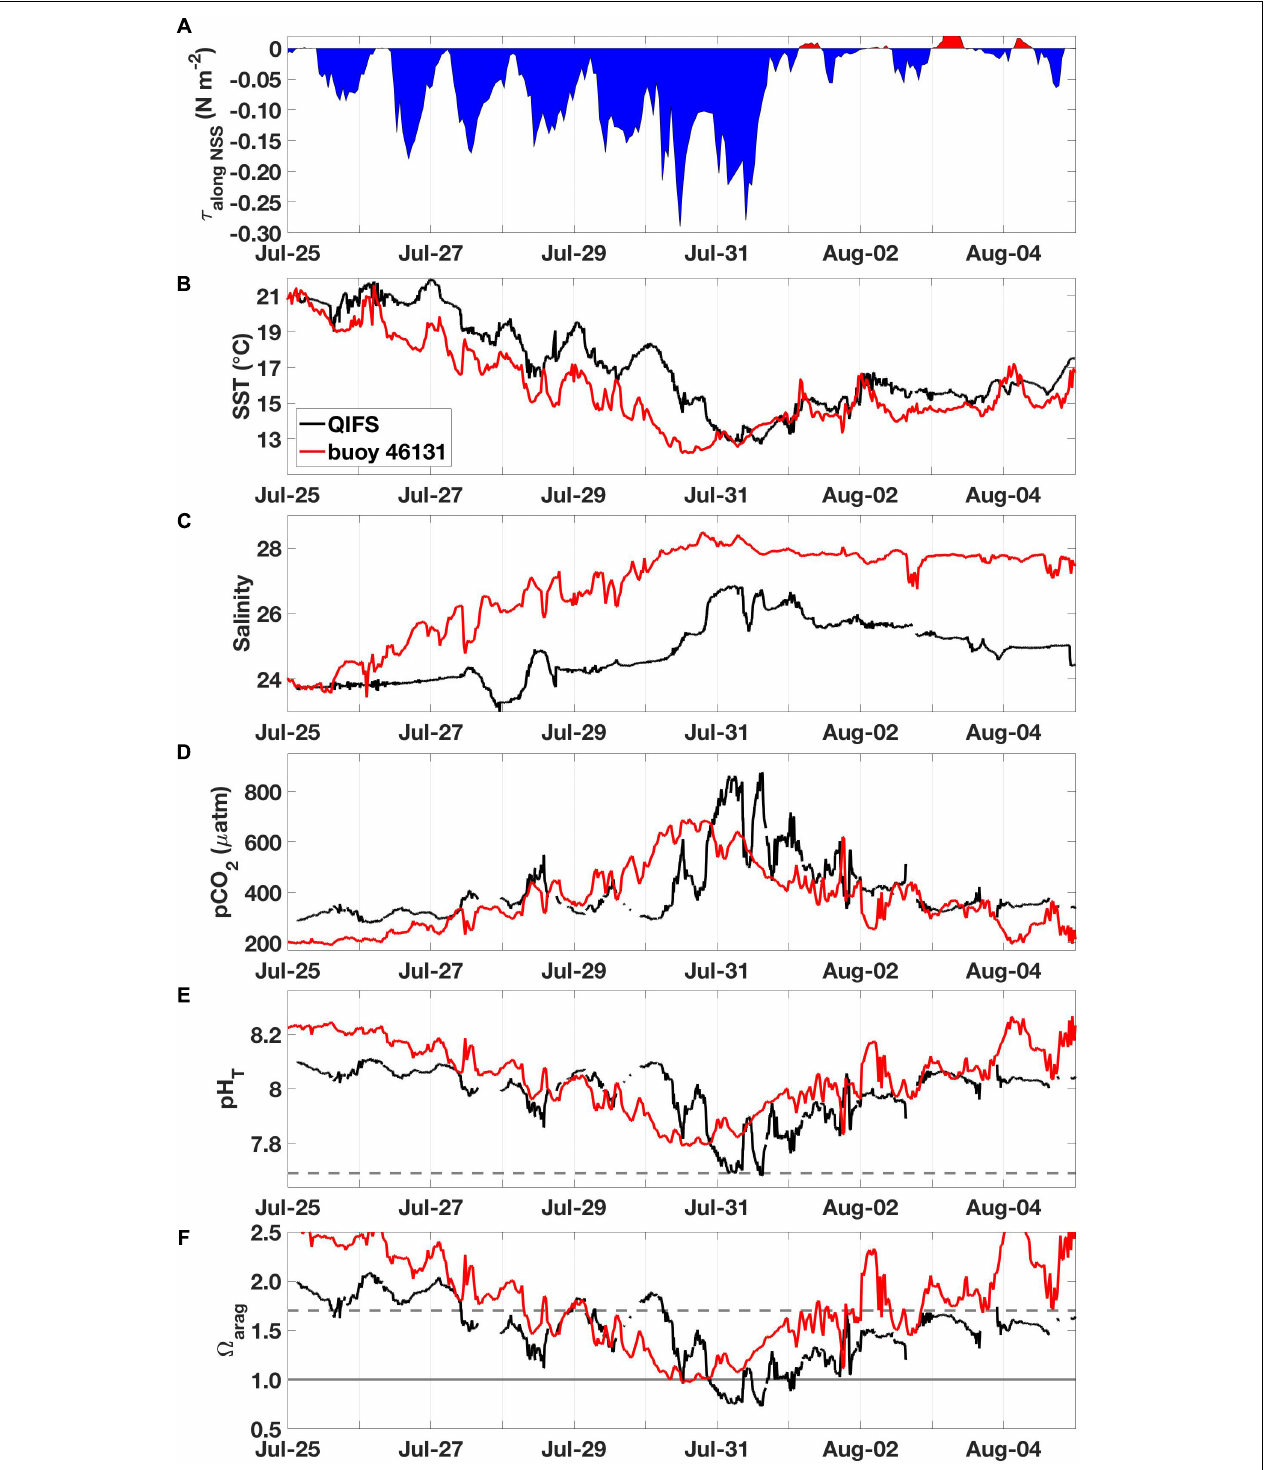
FIGURE 5 | Observations made during the July 2016 high-CO 2 event, including: (A) along-axis wind stress ( τ alongNSS ; N m − 2 ) from buoy 46131, (B) SST ( ◦ C) from QIFS and buoy 46131, (C) salinity from QIFS and buoy 46131, (D) seawater pCO 2 ( µ atm) from QIFS and buoy 46131, (E) pH T from QIFS and buoy 46131, and (F) (cid:127) arag from QIFS and buoy 46131. All QIFS data are black while buoy 46131 data are red. The horizontal line in (E) marks pH T = 7.69, and the horizontal lines in (F) mark (cid:127) arag = 1 (solid gray) and (cid:127) arag = 1.7 (dashed gray).